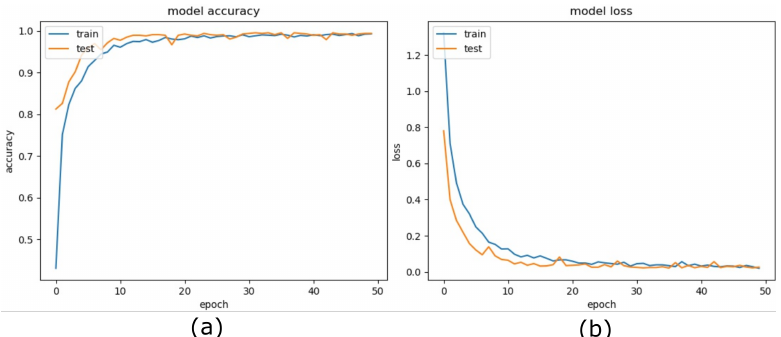
Figure 4. Proposed model training history. ( a ) Model accuracy, ( b ) Model